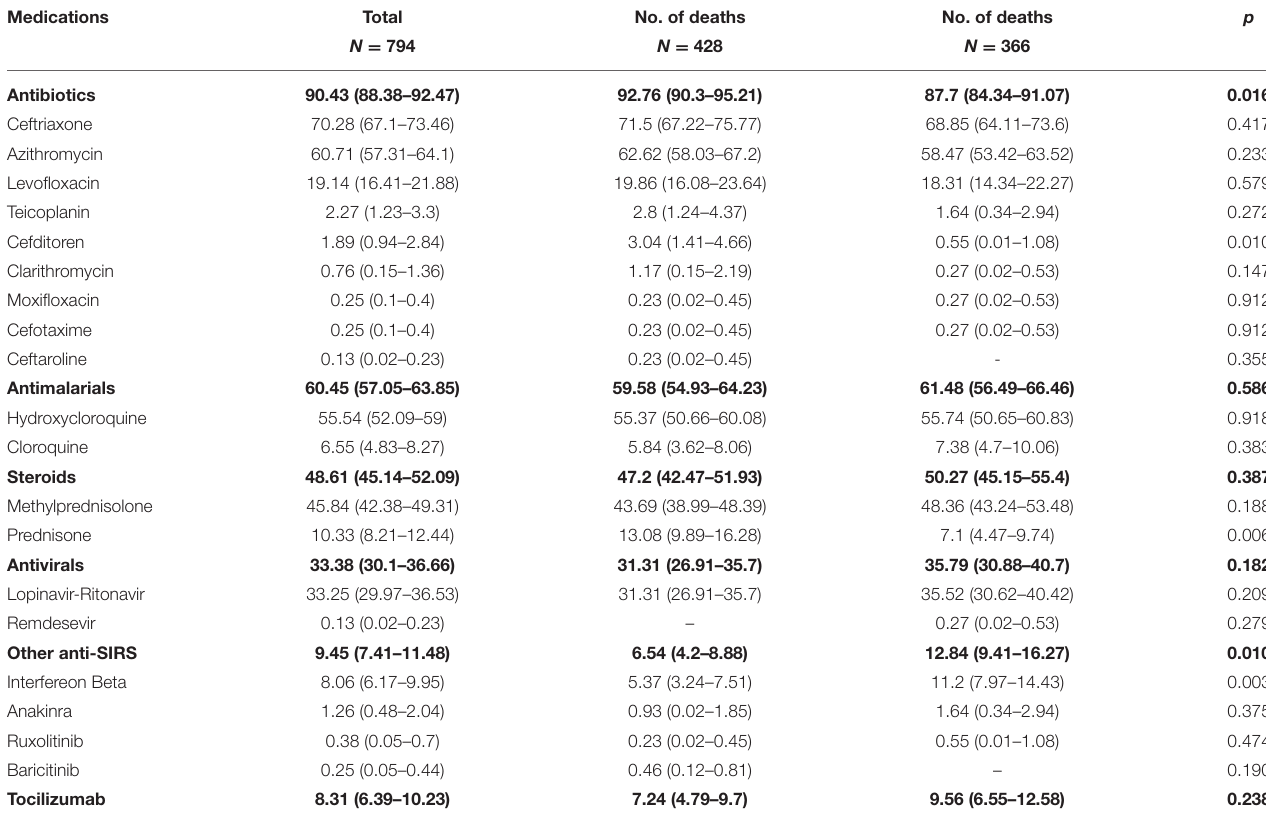
TABLE 2 | Medications used by in-hospital COVID-19 patients with acute kidney injury (AKI) in Castile and Leon (Spain) (March 1st–May 31th 2020).